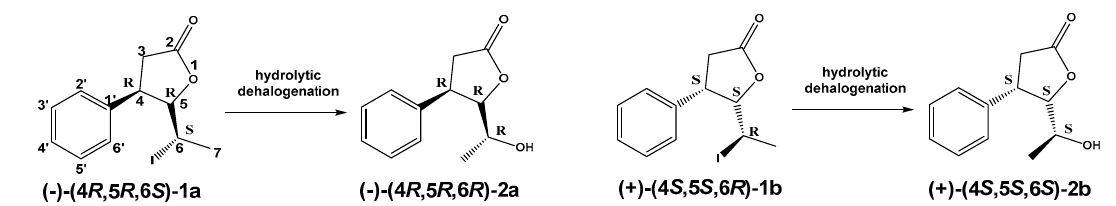
Figure 3. Hydrolytic dehalogenation of cis -5-(1-hydroxyethyl)-4-phenyldihydrofuran-2-one enantiomers and predicted configuration of stereogenic centers of products.